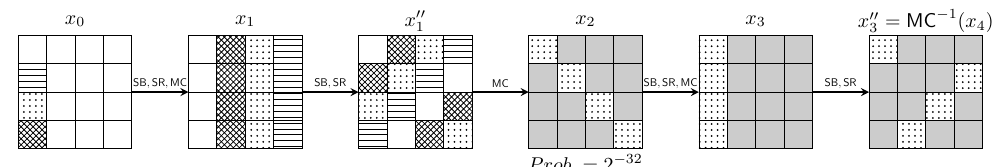
Figure 2. A 4-round AES mixture differential trail with probability 2 − 32 . ( ARK layer omitted as it does not influence pattern